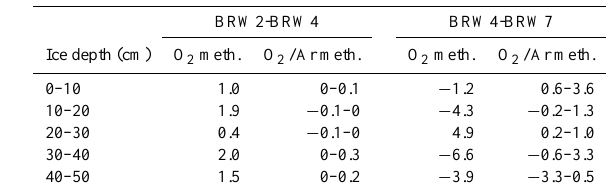
Figure 7. [O 2 ] bio in BRW10 calculated following Eq. (3). The re- sults may be converted into C uptake, assuming a photosynthetic quotient O 2 /C of 1.43 (Glud et al.,